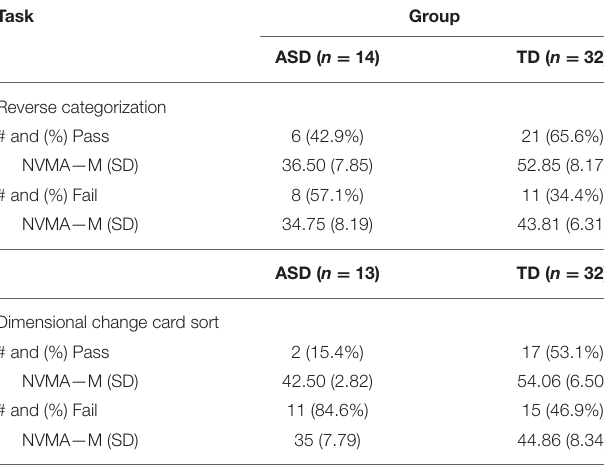
Groups are not matched on non-verbal mental age.